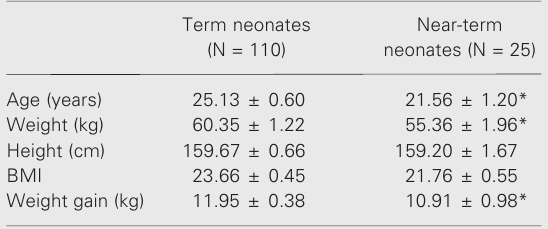
Table 1. Clinical characteristics of the mothers.